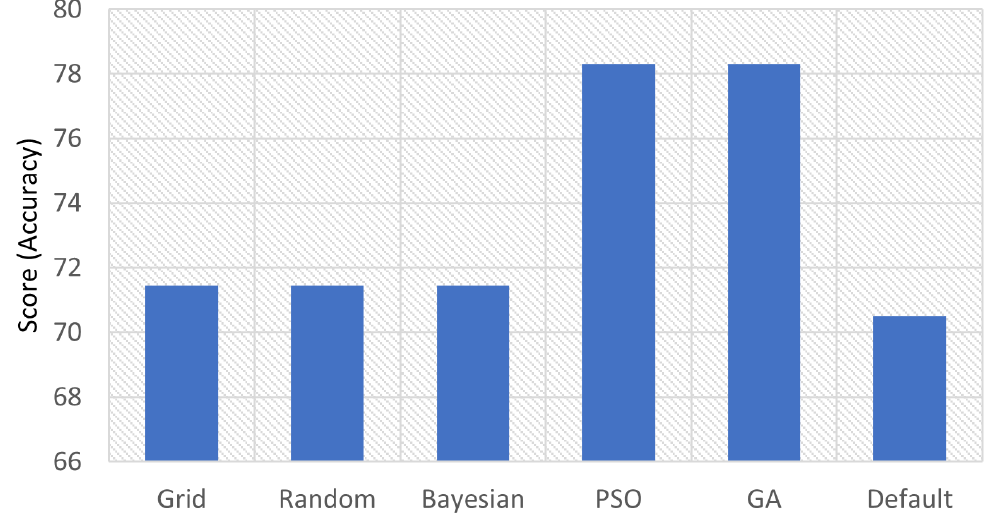
Figure 19. Hyperparameter tuning techniques versus score for